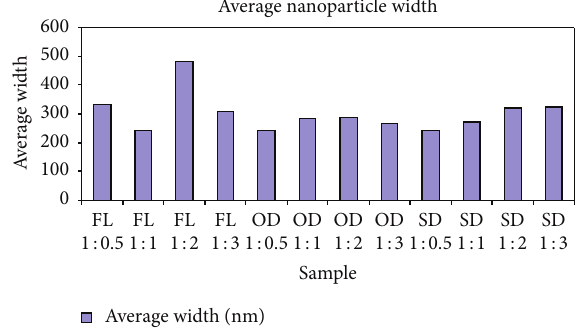
Figure 5: Average number of silver nanoparticles synthesized from the leaf extracts of Pimenta dioica under different conditions.